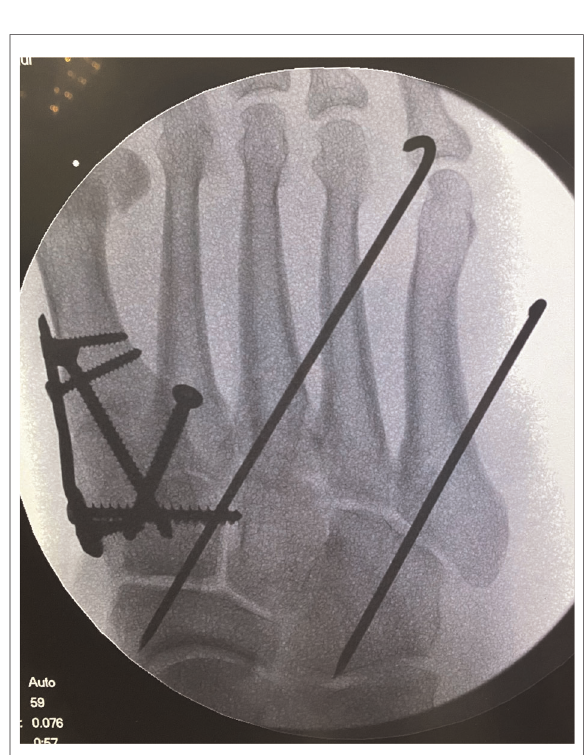
Orthopedic Foot and Ankle Society (AOFAS) midfoot scores and visual analog scale (VAS) scores were used for assessment at the fi nal follow-up.